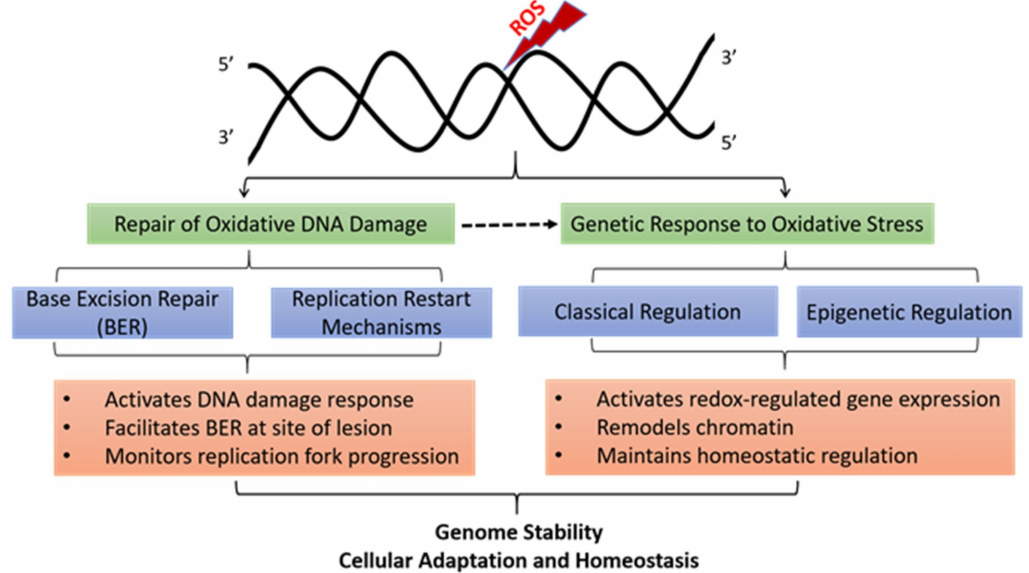
Figure 1. Mechanisms of oxidative-stress-induced genetic and epigenetic alterations. Damage to DNA bases due to oxidative stress induced from the plethora of extracellular and intracellular factors is deleterious, leading to stalled replication forks and mutations. Mammalian cells utilize the base excision repair (BER) pathway alone and in concert with various replication restart mechanisms to get rid of oxidative lesions and ensure faithful duplication of genome. Genetic response to oxidative stress involves alteration in gene expression by both the classical gene regulatory mechanisms and by epigenetic processes. Classical gene regulation implicates transcription-factor based gene regulation to influence gene transcription. Epigenetic mechanisms are those that do not involve changes in the genome sequence, but rather in nuclear architecture, chromosome conformation, and histone and DNA modifications. For example, epigenetic involvement of ROS has been attributed to oxidative conversion of 5-mC to 5-hmC. Oxidative conversion of G to 8-oxoG at the promoter regions activates expression of redox-regulated genes suggesting that oxidative base modification may also represent an epigenetic mark serving as sensors of oxidative stress. Involvement of DNA repair (largely BER) in coordinating the gene regulatory response to oxidative stress is indicated by dashed